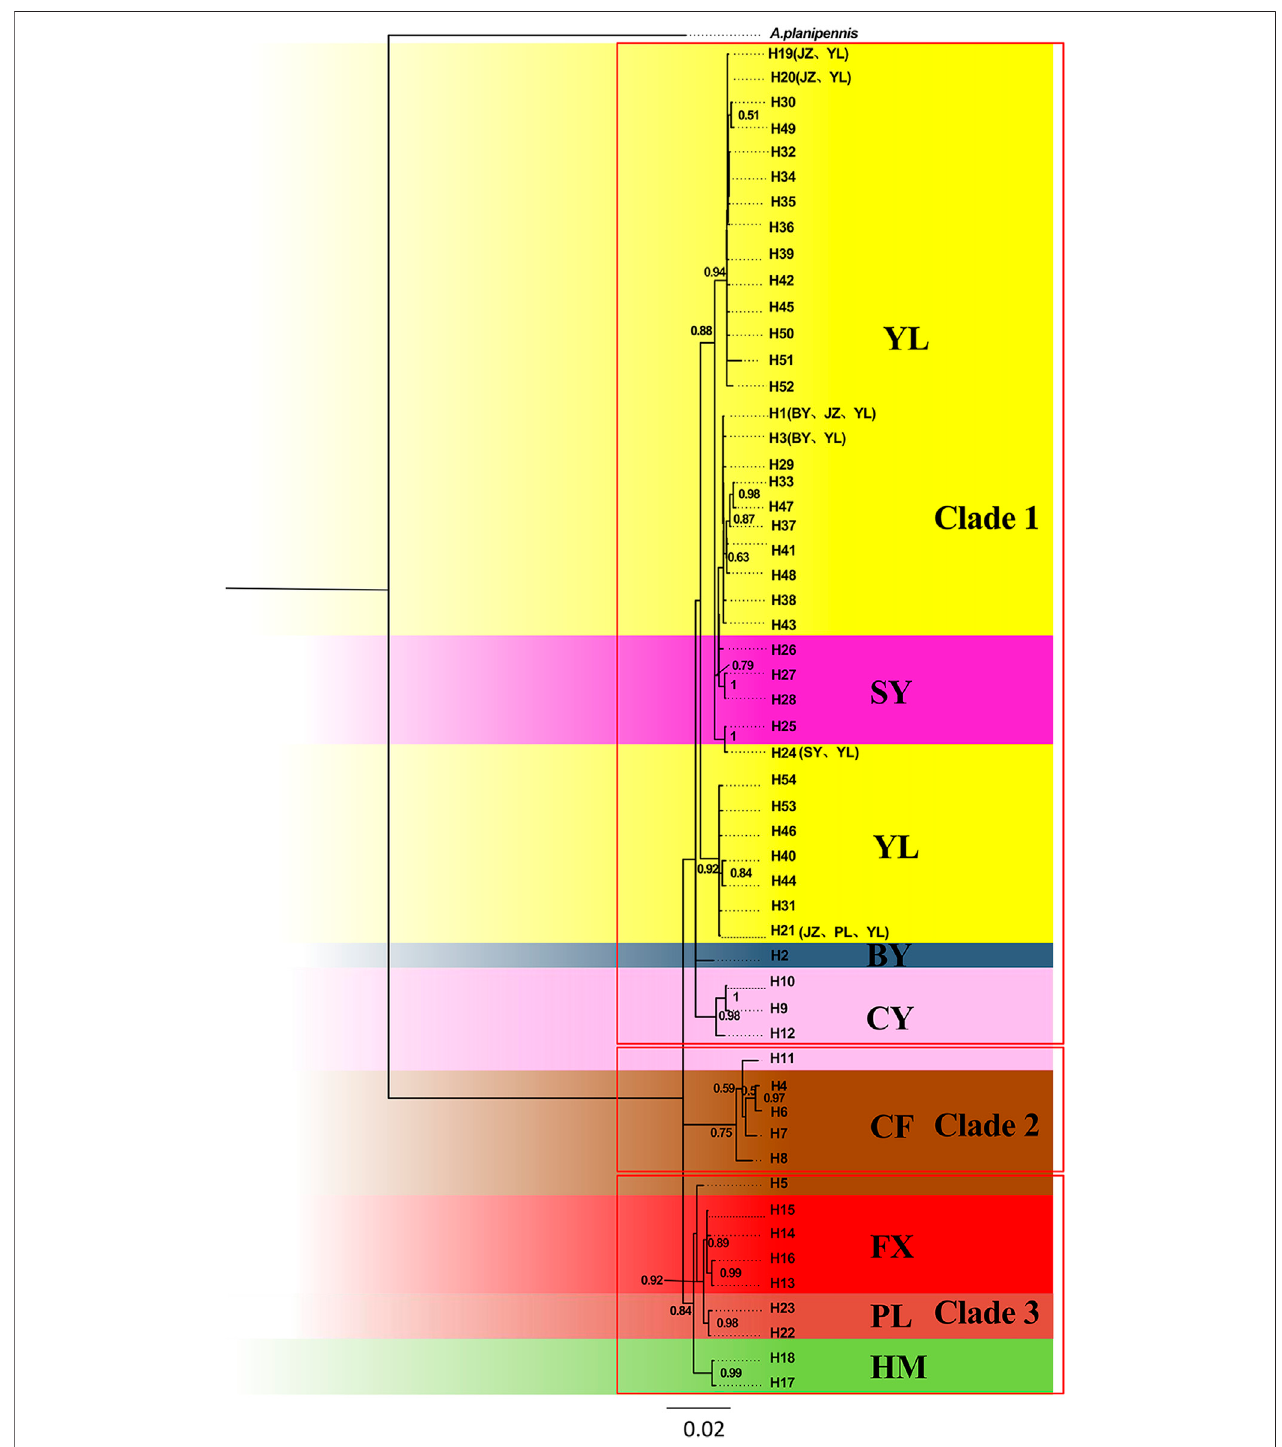
FIGURE 3 | Bayesian inference (BI) phylogenetic tree inferred from haplotypes based on combined genes.